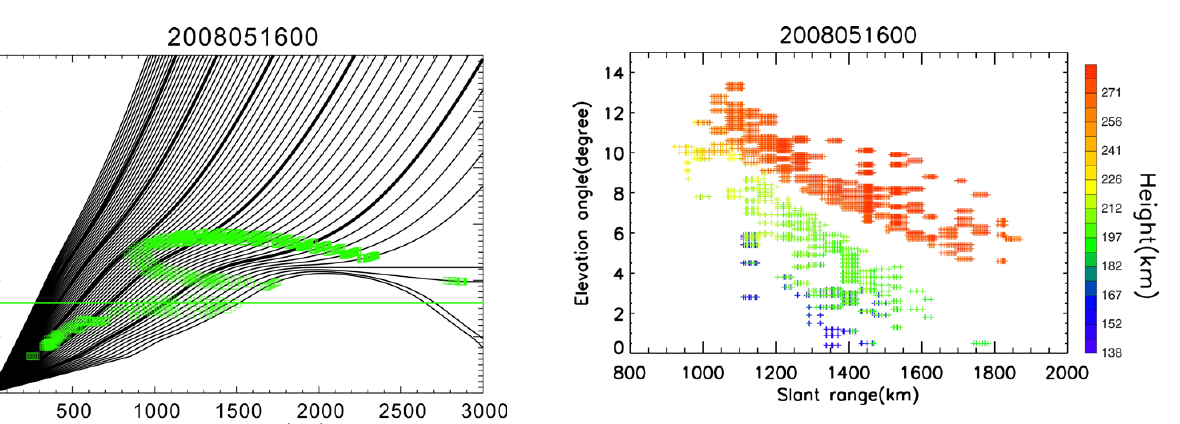
Fig. 3. Height distribution of ionospheric backscatter echoes for the event in Fig. 1. The different color represents the height from ray tracing